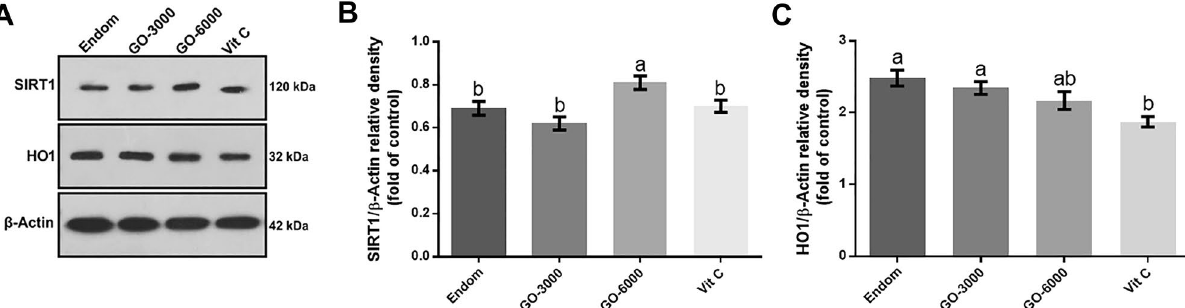
Figure 2. Effect of gamma-oryzanol on relative protein expressions assessed by Western blot. Representative Western blot bands of SIRT1, HO-1 and β-actin ( A ) and the relative protein expression of SIRT1 ( B ) and HO-1 ( C ) in experimental groups. These proteins were normalized by β-actin and reported as relative change compared to endom-group. The result showed the increased expression of SIRT1 in the rats treated with GO-6000 compared to the other groups ( P < 0.05). The level of HO-1 protein significantly decreased in Vit C group compared to GO-3000 and endom-groups ( P < 0.05 ). The superscripts (a,b) display differences among groups.